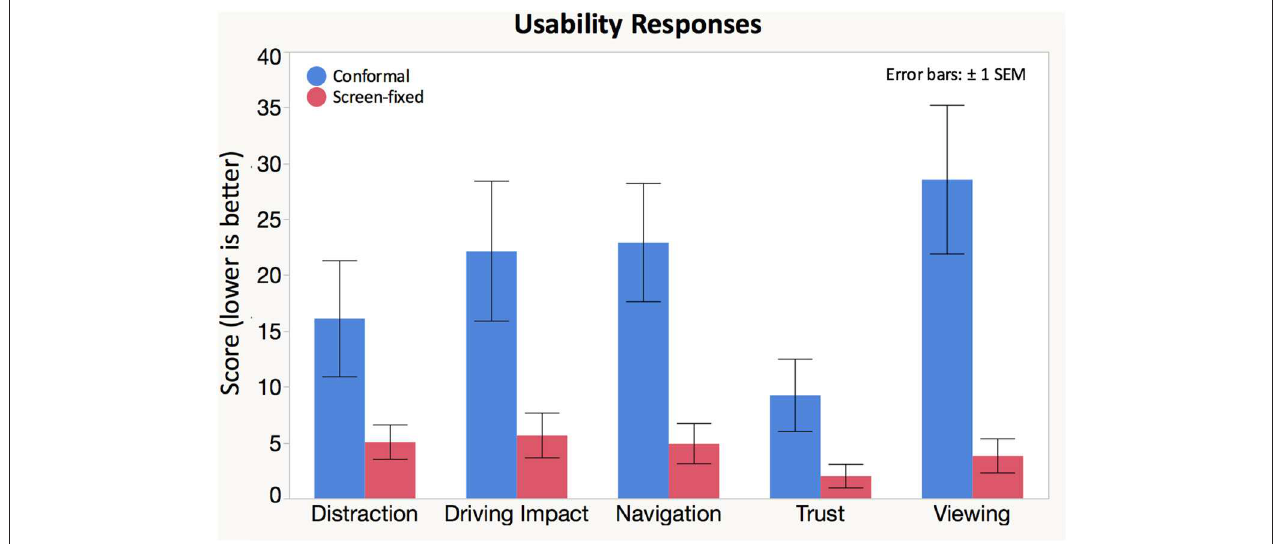
FIGURE 7 | Participants rated the following statements on a scale of 0 (strongly agree) to 100 (strongly disagree): (1) “I did not find this interface distracting.” (2) “Using this interface had a positive impact on my driving.” (3) “It was easy to navigate while using this interface.” (4) “I trusted the information on this interface.” and (5) “The interface was easy to view”.